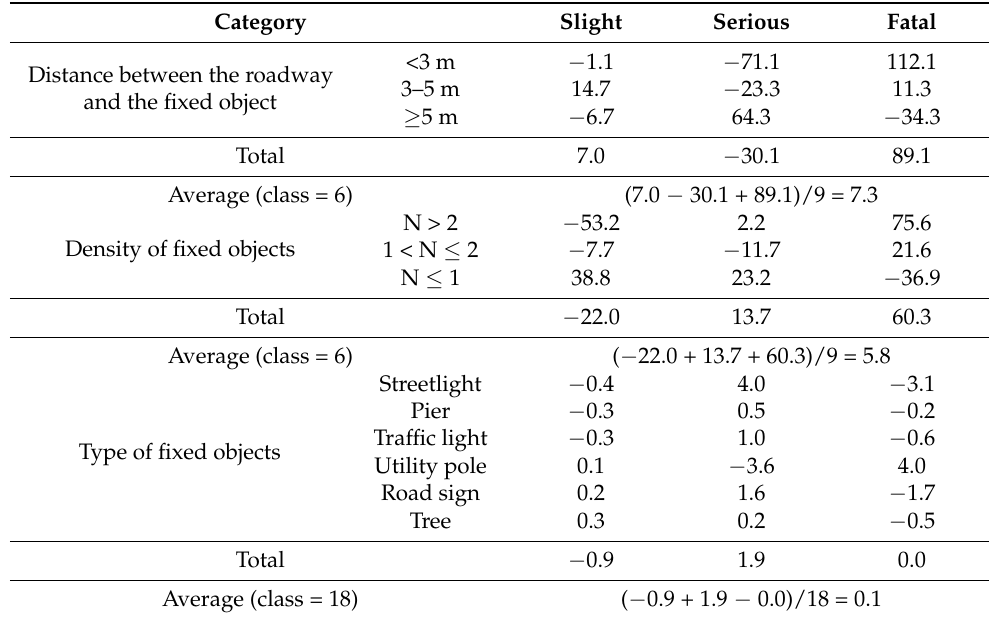
Table 7. Results of the roadside fixed object variable threshold